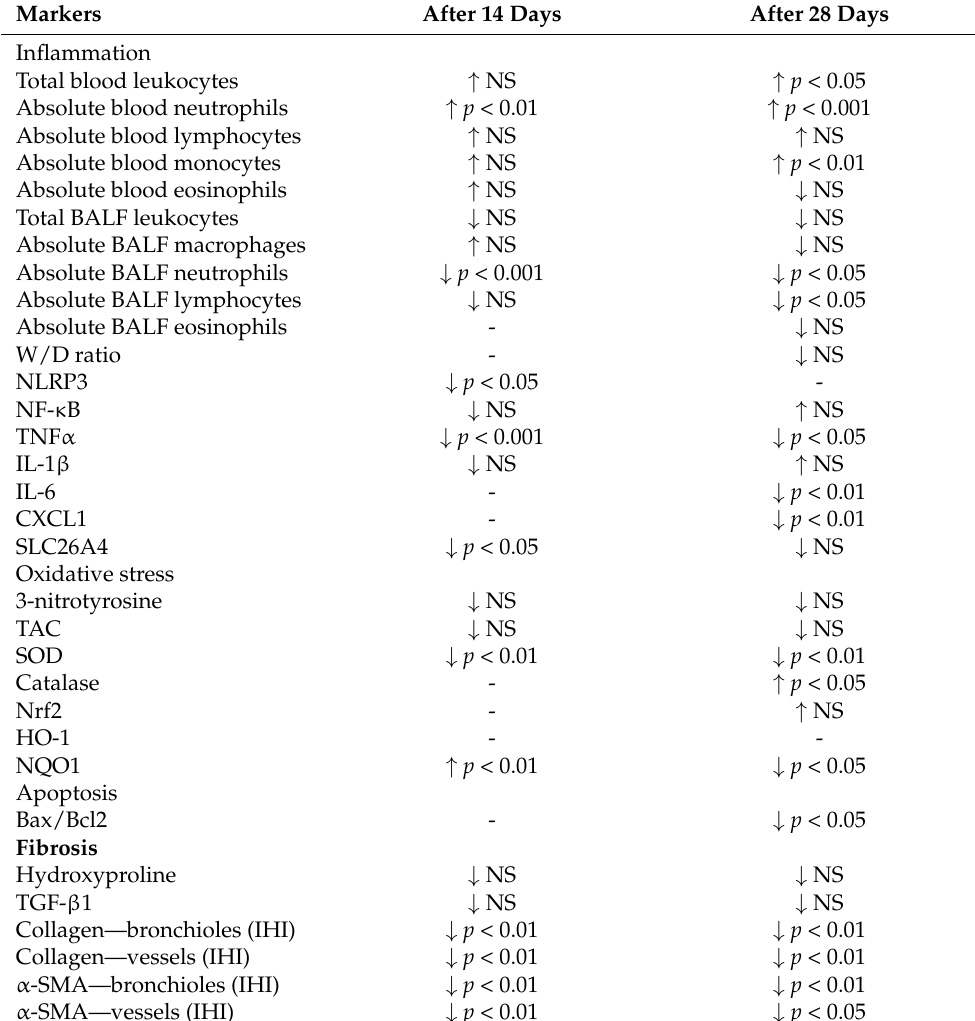
Table 3. Summarization of effects of EGCG treatment (EGCG14d and EGCG28d groups) on different markers of inflammation, oxidative stress, apoptosis, and fibrosis after 14 days or 28 days of the experiment compared to silica-instilled and EGCG non-treated animals (Model14d and Model28d